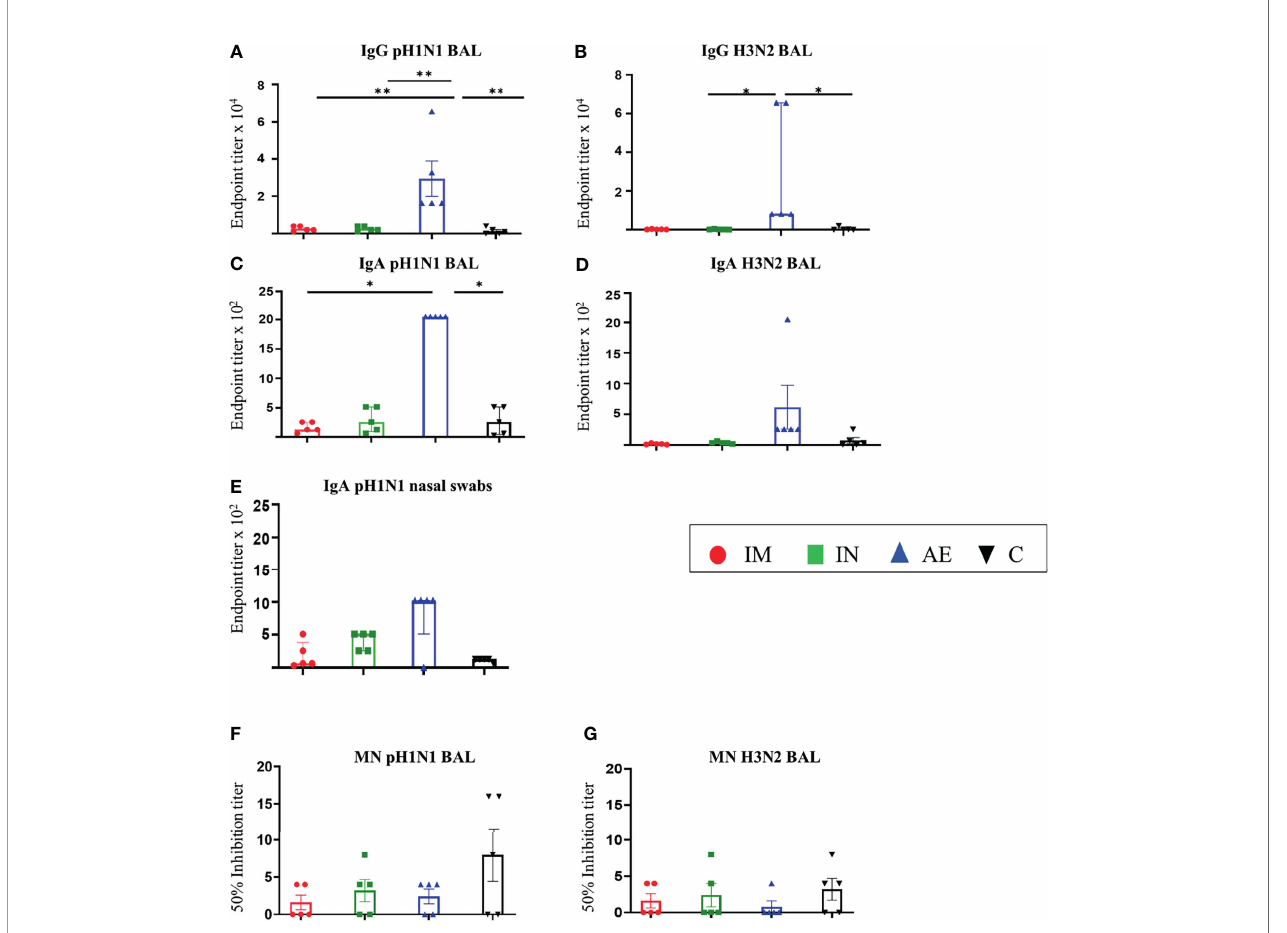
FIGURE 2 | Mucosal antibody responses. (A – D) pH1N1- and H3N2-speci fi c IgG and IgA responses in BAL and (E) pH1N1-speci fi c IgA responses in nasal swabs were determined by ELISA 4 weeks after immunization. (F, G) BAL-neutralizing titers were determined by microneutralization (MN) of (F) pH1N1 and (G) H3N2 4 weeks after immunization. For graphs (B, C, E) , Kruskal – Wallis and Dunn ’ s multiple comparisons tests were performed, and the top of these bars indicates the median and the line the interquartile range. The rest of the graphs were analyzed by one-way ANOVA and Bonferroni ’ s multiple comparisons test, and the top of each bar indicates the mean and the line the standard error mean (SEM). Each symbol (circle, square, and triangles) represents one animal. Asterisks denote signi fi cance between indicated groups (*p < 0.05 and **p <